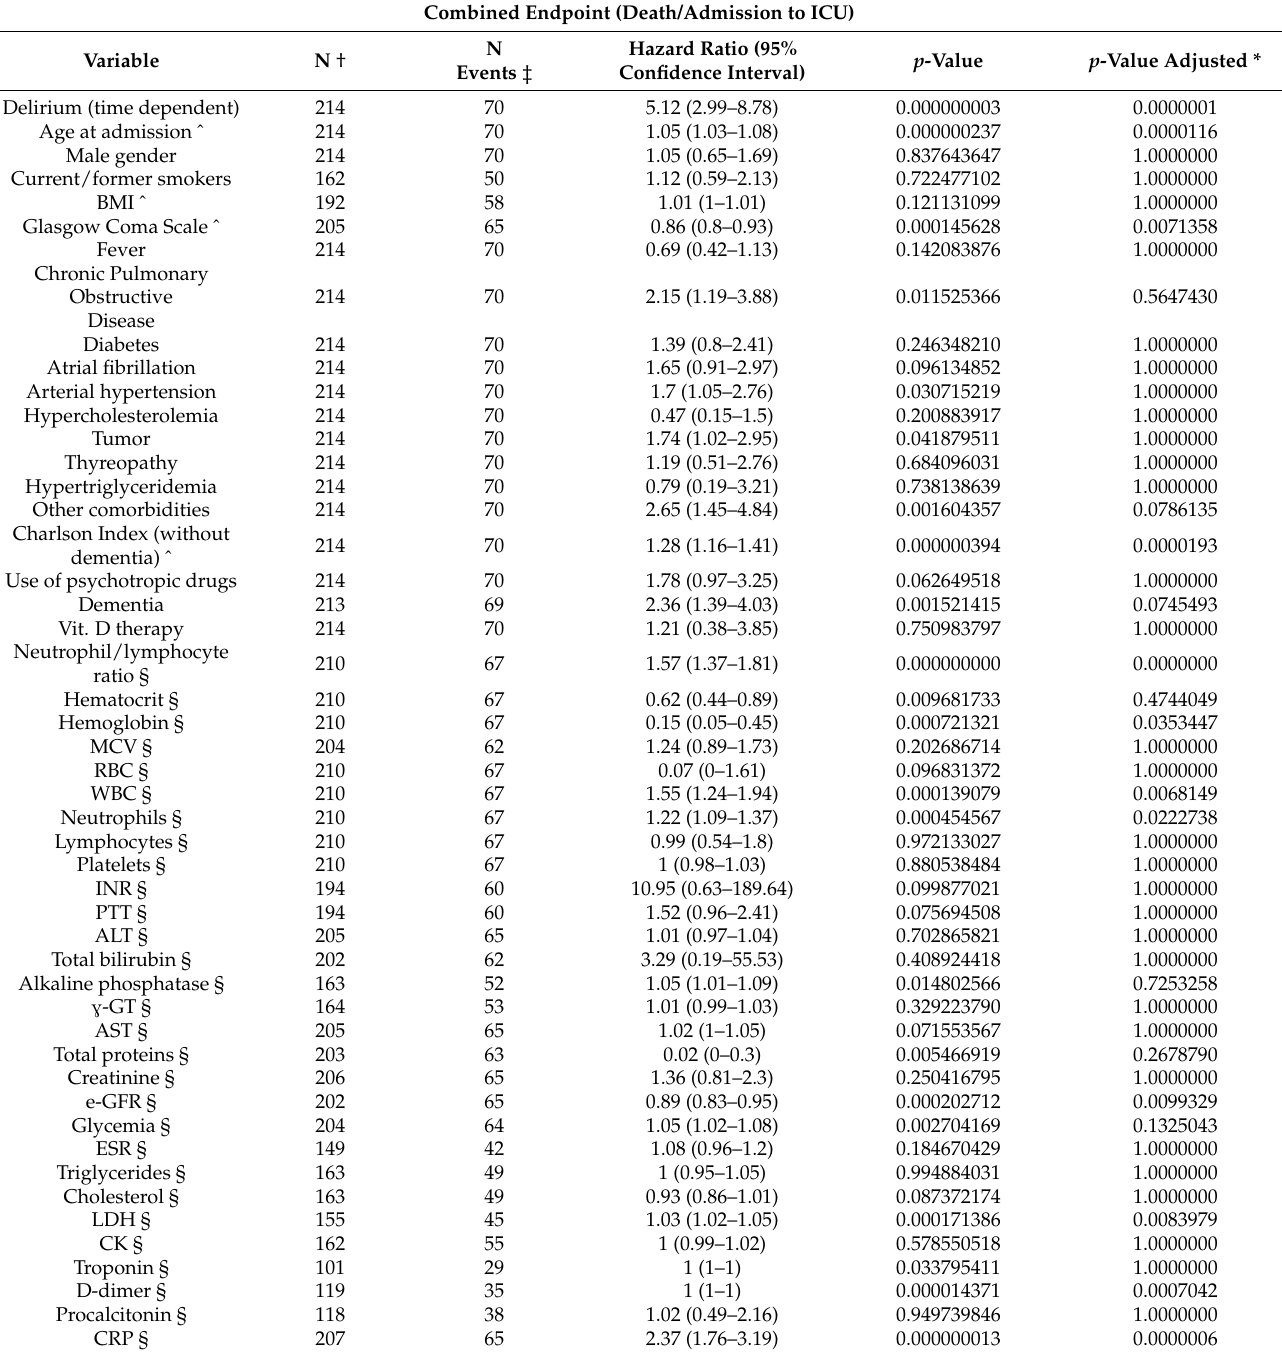
Table 6. Association between baseline clinical and laboratory variables and the combined endpoint (death or admission to